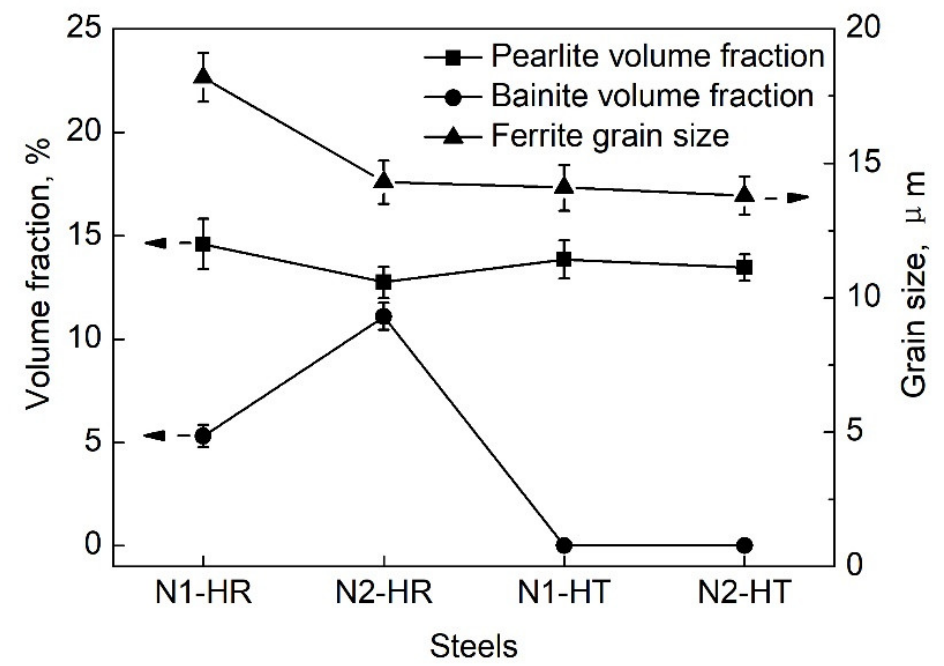
Figure 5. The variation trends of pearlite volume fraction, bainite volume fraction, and ferrite grain size.